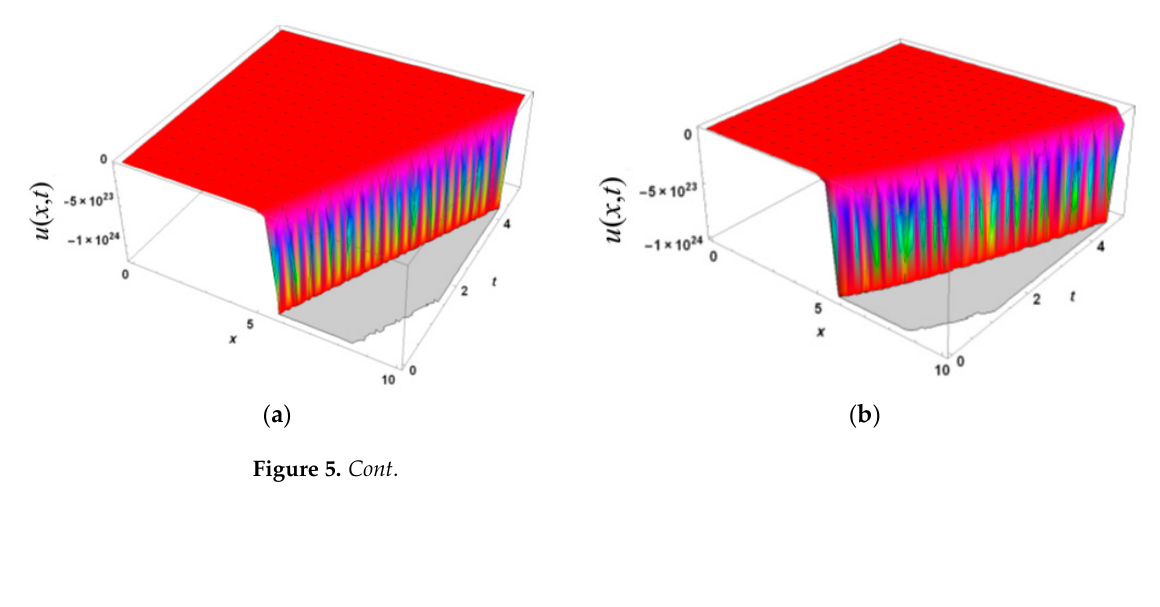
Figure 4. For Equation (31), ( a – d ) with 0 ≤ x ≤ 10 and 0 ≤ t ≤ 5 express the 3D profiles, ( e – h ) show the contour profiles for 0 ≤ x ≤ 10 and 0 ≤ t ≤ 5, and ( i ) indicates the 2D representation of a range of values of α . ( a ) α = 1, ( b ) α = 0.8, ( c ) α = 0.5, ( d ) α = 0.25, ( e ) α = 1, ( f ) α = 0.8, ( g ) α = 0.5, and ( h ) α = 0.25.